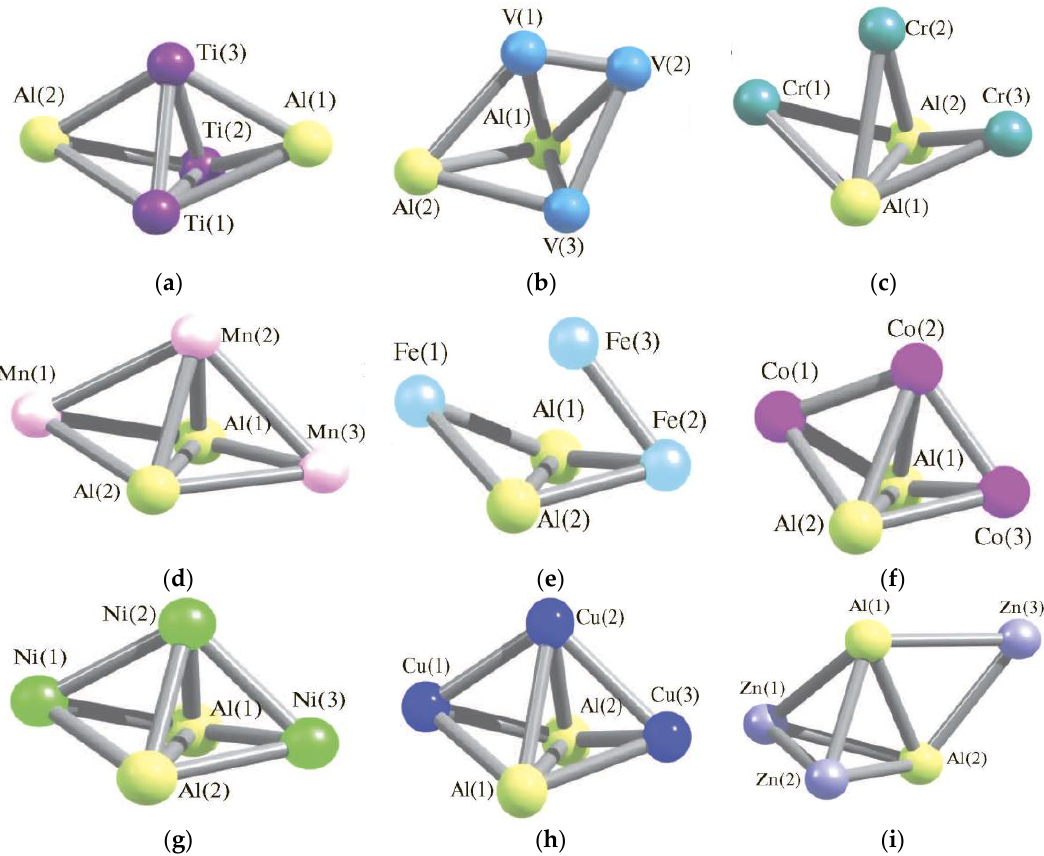
Figure 4. The images of molecular structures of most energetic stable Al 2 M 3 metal clusters (M—3d-element) [92,93]: ( a )—Al 2 Ti 3 , ( b )—Al 2 V 3 , ( c )—Al 2 Cr 3 , ( d )—Al 2 Mn 3 , ( e )—Al 2 Fe 3 , ( f )—Al 2 Co 3 , ( g )—